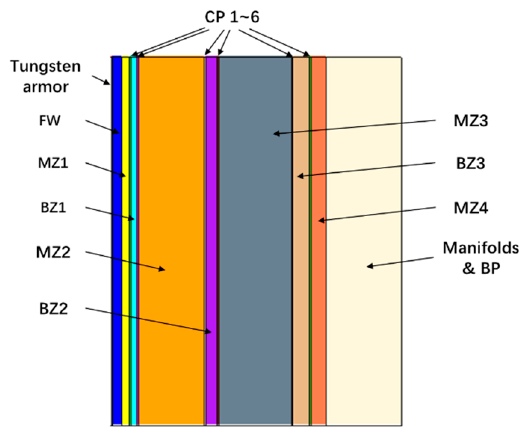
Figure 6. Radial layout of the 1D HCSB neutronics model.